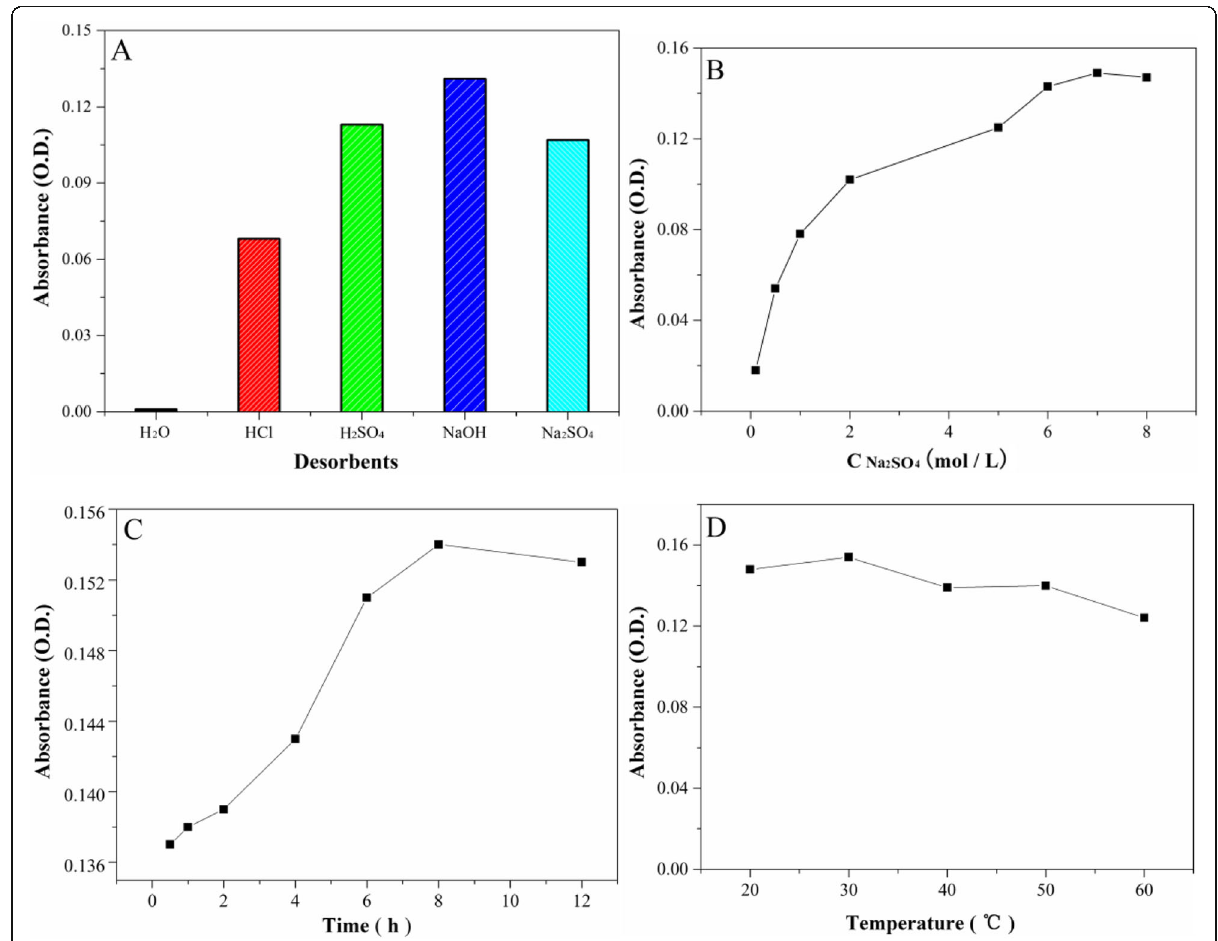
Fig. 4 Effect of desorbent ( a ), desorbent concentration ( b ), time ( c ), and temperature ( d ) on the amaranth desorption. (pH 1, adsorbent dosage 0.24g, adsorbent time 3h, adsorbent temperature 20°C, amaranth 2mgL − 1 , adsorption volume 10mL, oscillation speed 200rpm, desorption volume